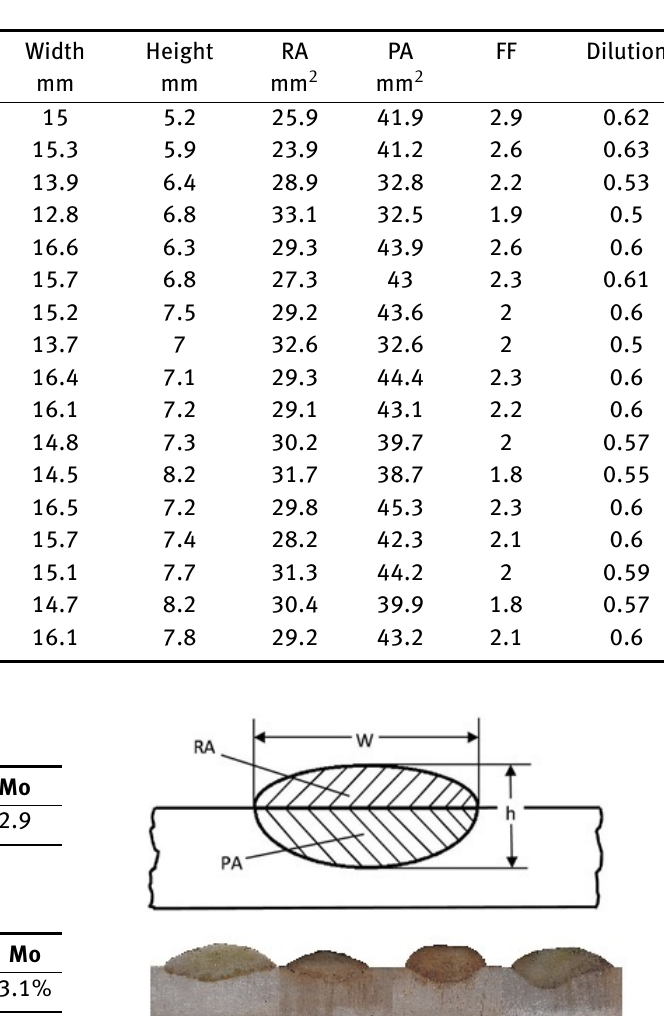
Figure 1: Bead profile indicating different bead characteristics and macrograph of actual bead